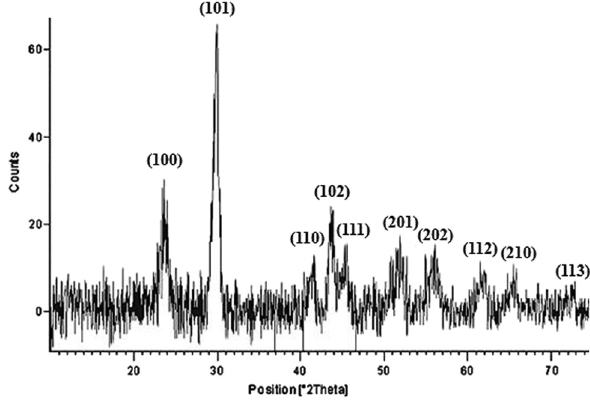
Figure 5: XRD spectrum of Sp SeNPs.